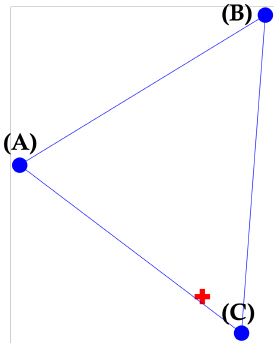
Figure 11. The location of 3 weather stations and the target PV site.